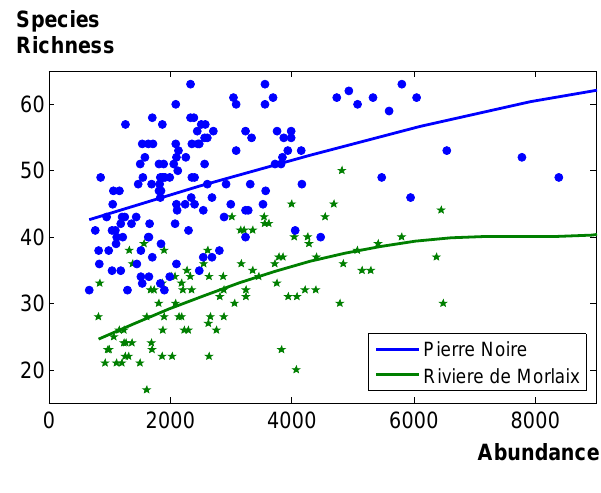
Fig. 4. Species richness versus total abundance for each sampling date. Conditional averages are shown as continuous